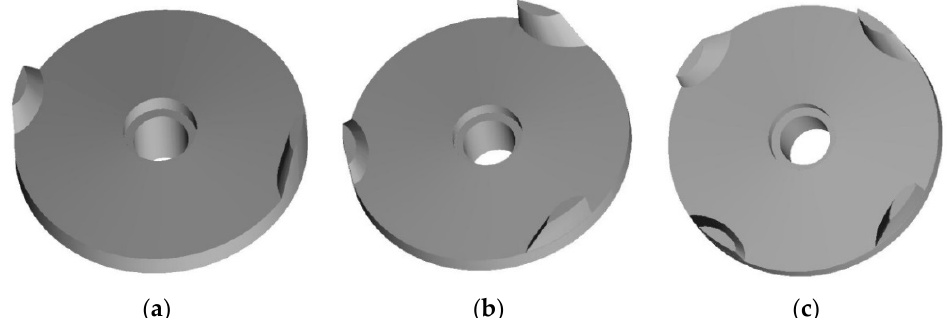
Figure 17. Streamlined cutter head of different numbers. ( a ) 2 cutter heads, ( b ) 3 cutter heads, ( c ) 4 cutter heads.